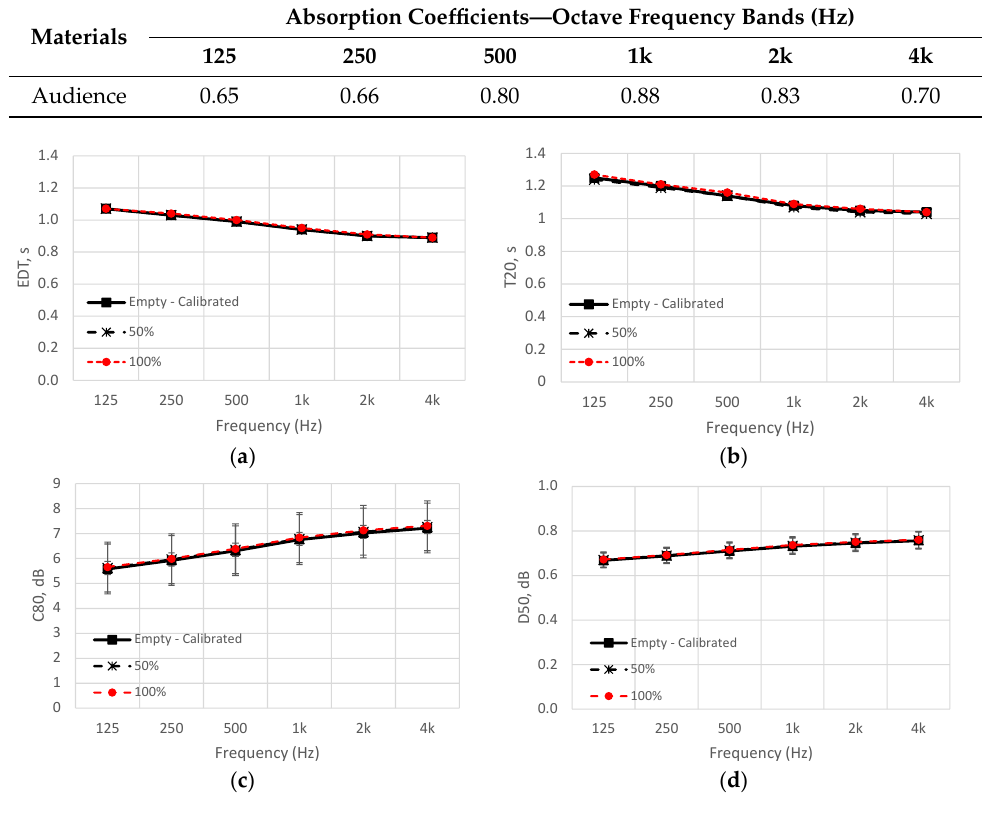
Table 6. Absorption coefficients of the audience considered in the model of Ponchielli theater of Cremona.